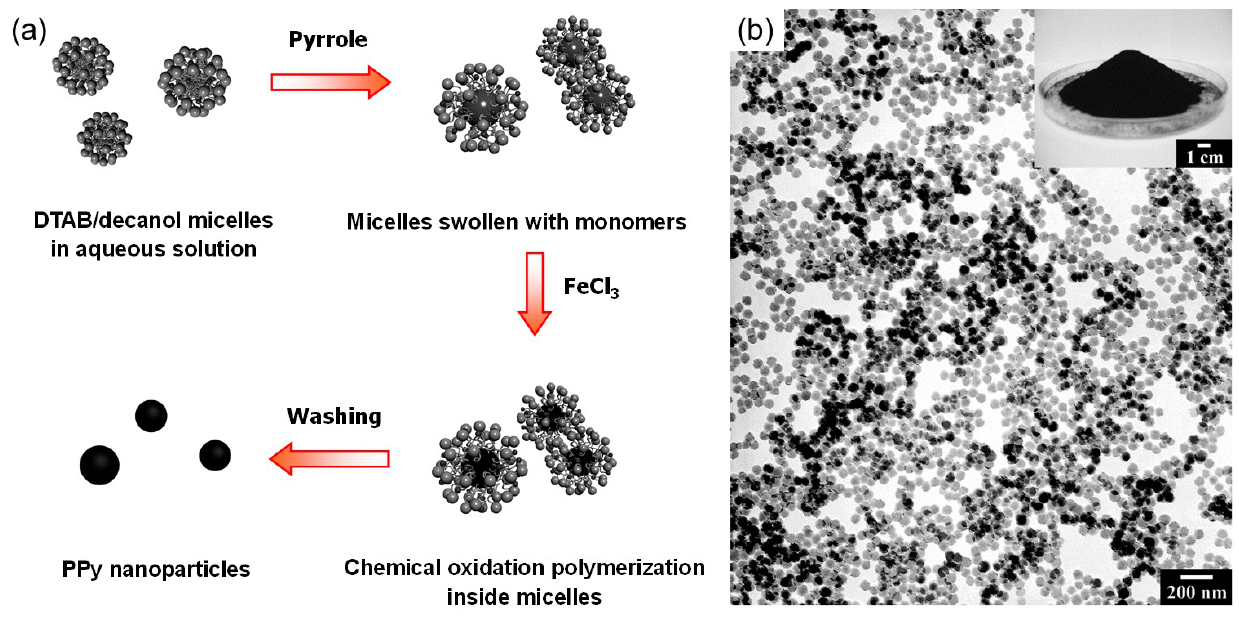
(DTAB)/co-surfactant (decanol) emulsion system; ( b ) TEM image